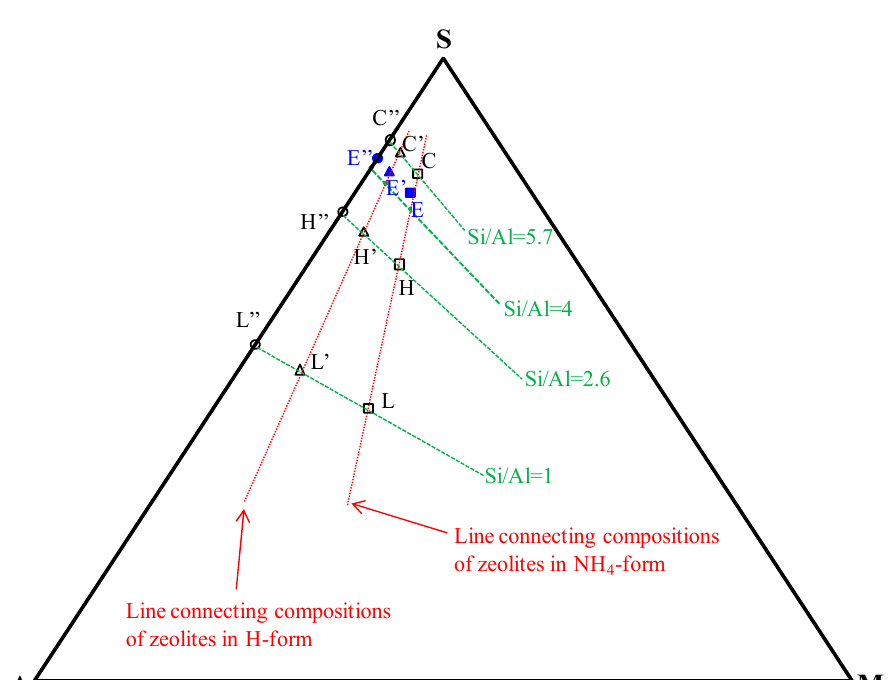
Figure 5. Ternary plot for M 2 O-Al 2 O 3 -SiO 2 system (values in wt %). S = silica; A = alumina; M = oxide of ammonium (for square marks) or hydrogen (for triangle marks). C = dehydrated NH 4 -clinoptilolite (Si/Al = 5.7); E = dehydrated ES-NH; H = dehydrated NH 4 -heulandite (Si/Al = 2.6); L = dehydrated NH 4 -LTA zeolite. C ′ , E ′ , H ′ , and L ′ : composition of the same materials after de-ammoniation. C”, E”, H”, and L”: composition of the same materials after